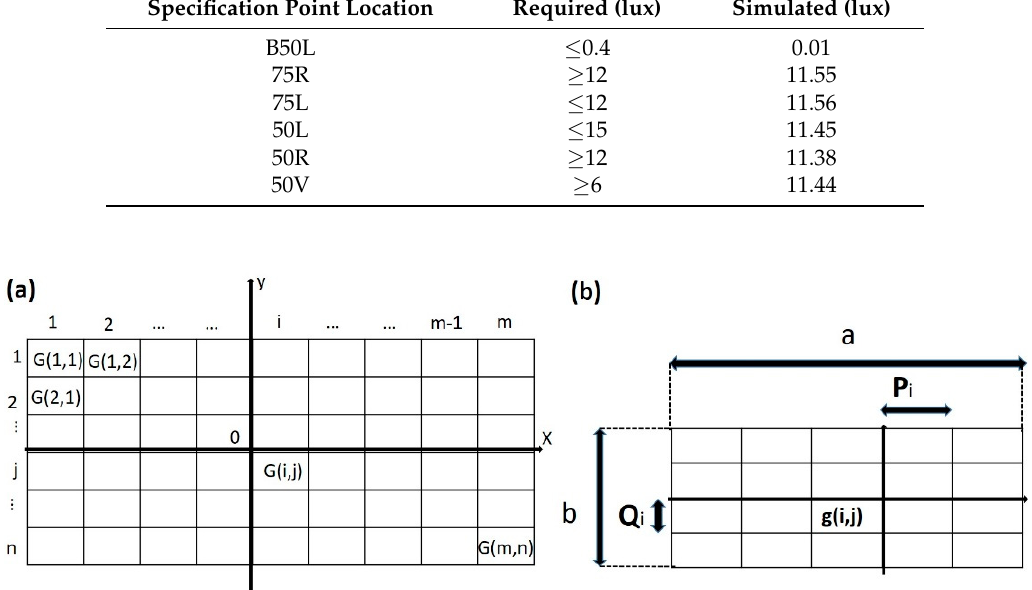
Figure 3. ( a ) Cutting diagram of light field of the work plane and ( b ) cutting diagram of the reflector.